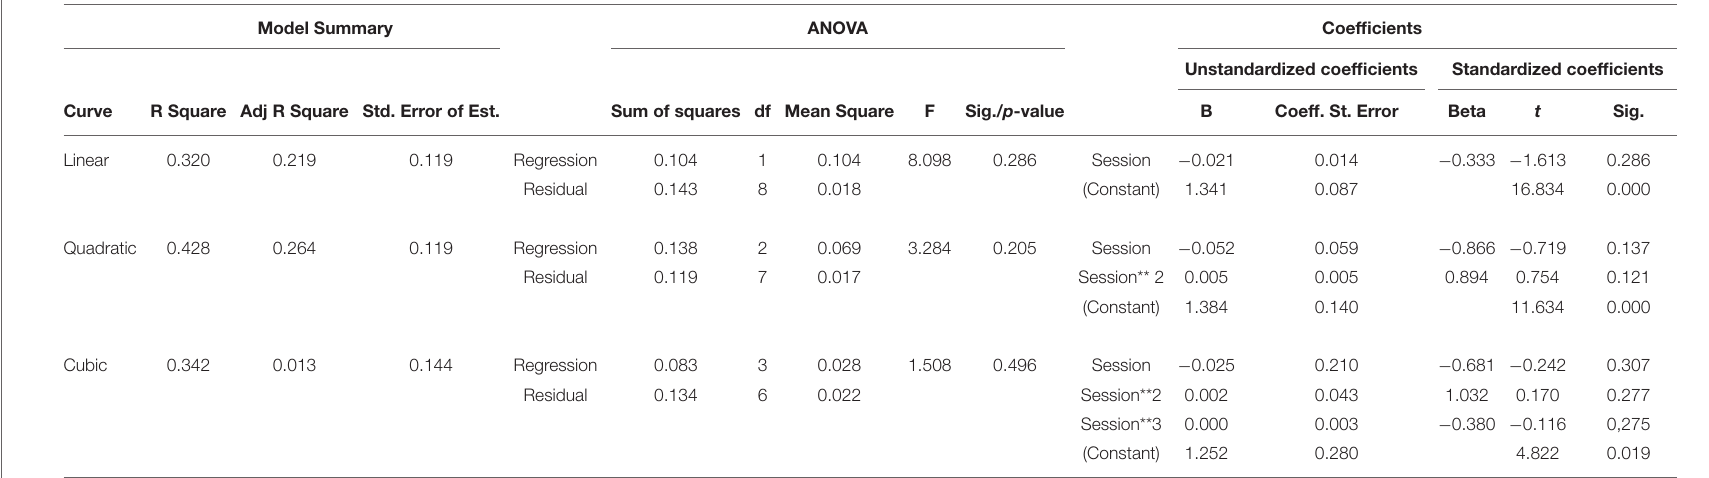
TABLE 3 | Mean linear and non-linear curve fit—dyads with 10 sessions. Mean linear and non-linear curve fit—dyads with 10 sessions Model Summary ANOVA Coefficients Unstandardized coefficients Curve R Square Adj R Square Std. Error of Est. Coeff. St. Error